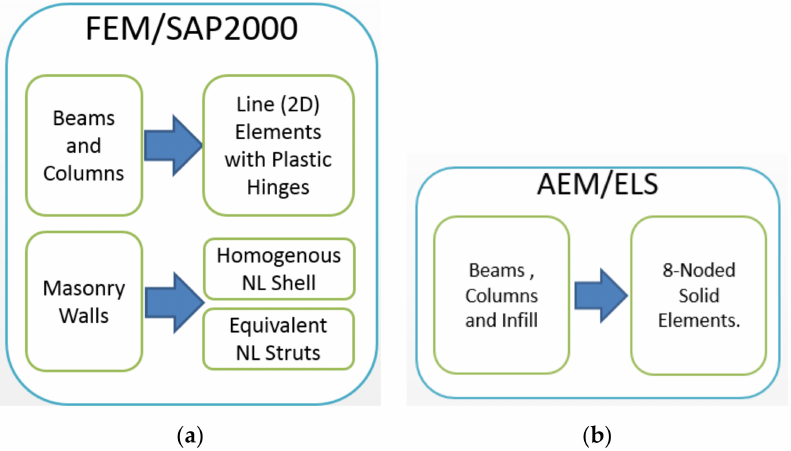
Figure 5. Modeling of structural elements using: ( a ) Finite Element Modelling; ( b ) Applied Element Modelling approach.